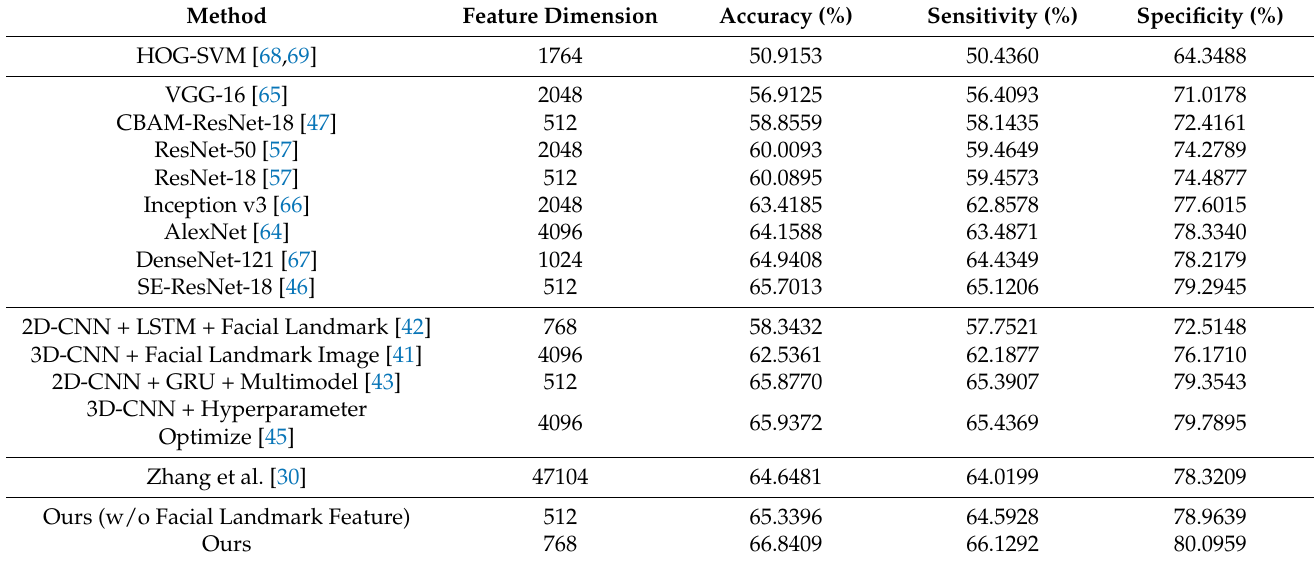
Table 10. Stress recognition accuracy, sensitivity, and specificity on the constructed database.